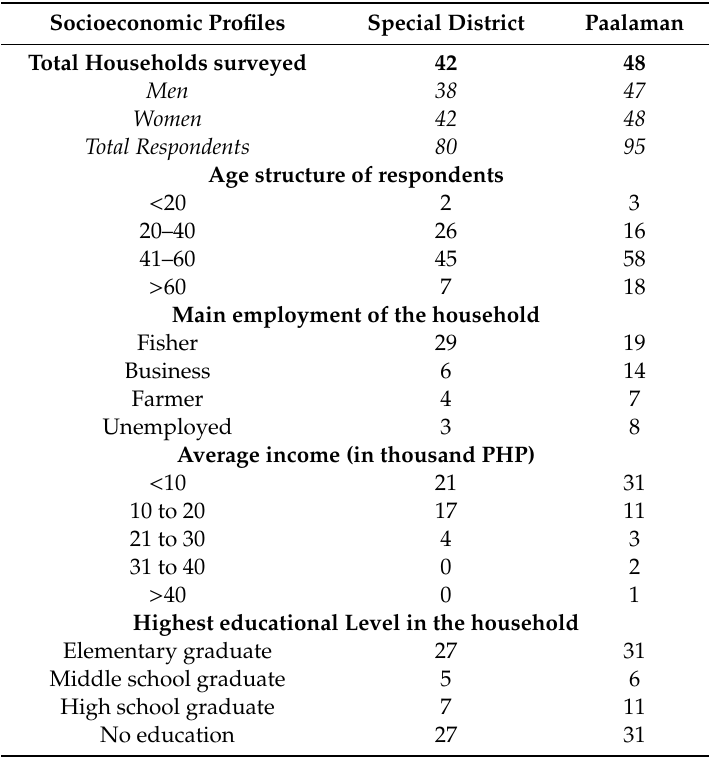
Table 2. Socioeconomic profile of the survey. Socioeconomic Profiles Special District